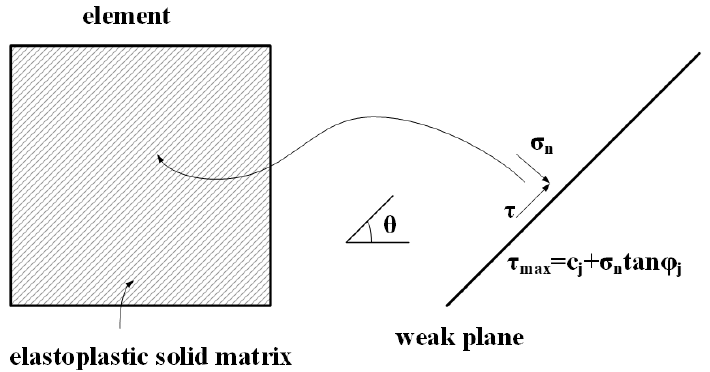
Figure 3. Schematic diagram of the ubiquitous joint model material.